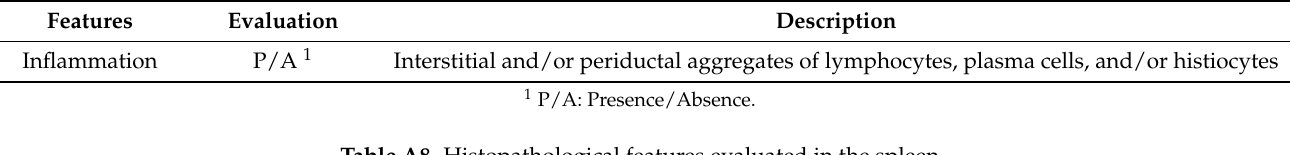
Table A8. Histopathological features evaluated in the